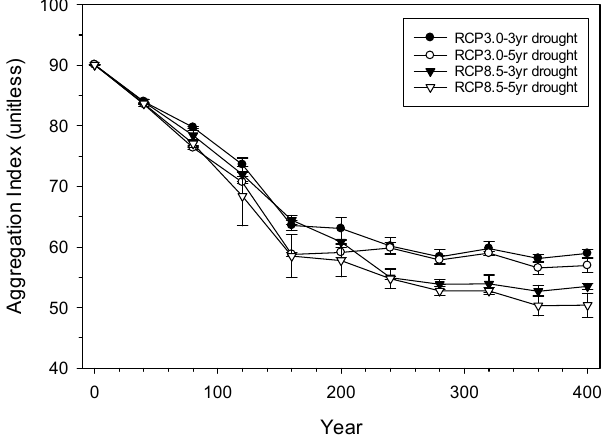
Figure 8. Change in mean richness measures on forested cells through simulated time.